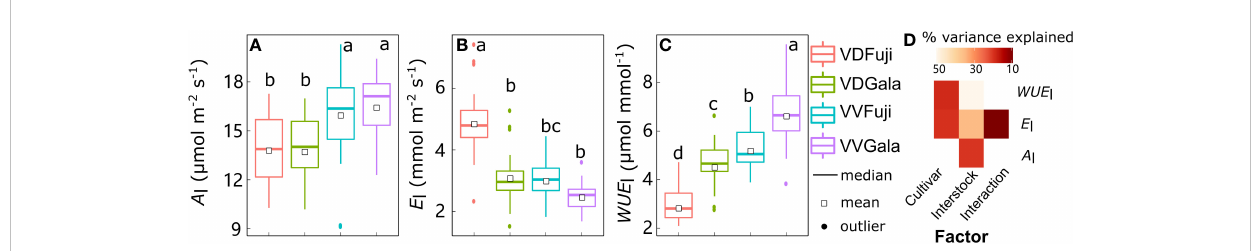
FIGURE 1 Boxplot of the leaf scale net photosynthesis rate ( A l ) (A) , transpiration ( E l ) (B) , and water use ef fi ciency ( WUE l ) (C) in ‘ Fuji ’ and ‘ Gala ’ apple trees grafted on vigorous rootstocks associated either with a dwarf M26 interstock (VD) or a vigorous ‘ Qinguan ’ interstock (VV), and the corresponding amount of variance explained by cultivar, interstock, and their interactions (D) . The percent variance explained by each factor in the model is indicated using color for those factors which explain a signi fi cant portion of the variance ( p <